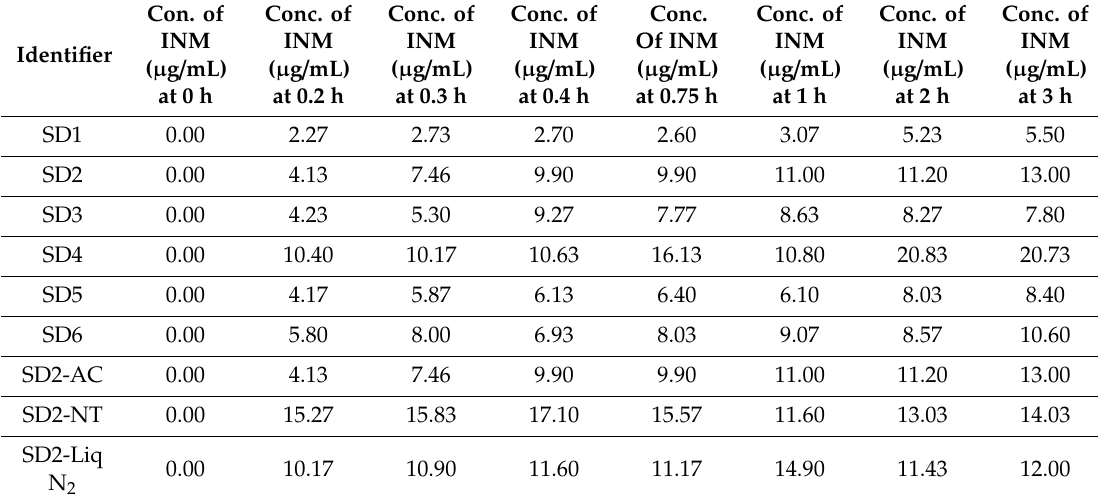
Table 9. Comparison of the aqueous solubility of INM from various quaternary and ternary SD formulations in pH bu ff er 1.2 taken at various time intervals over 24 h.